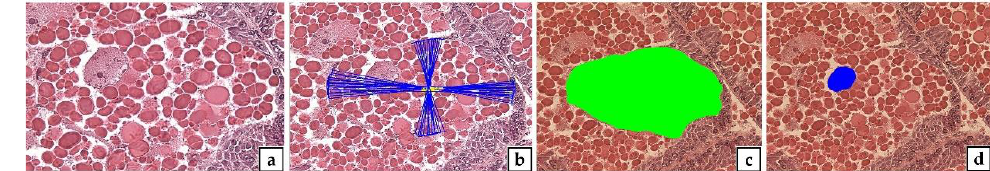
Figure 2. Microscopic image analysis of the oocytes. ( a ) original image; ( b ) analysis of oocyte size; ( c ) analysis of cytoplasmic area; ( d ) analysis of nucleus area.